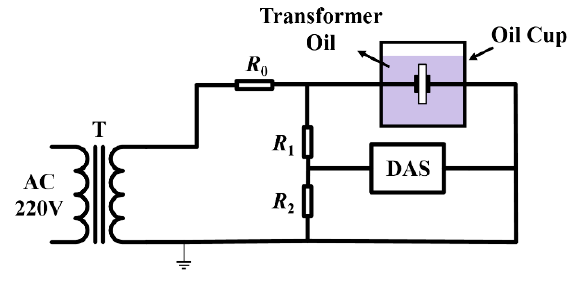
Figure 5. Schematic diagram of dielectric AC breakdown test circuit.